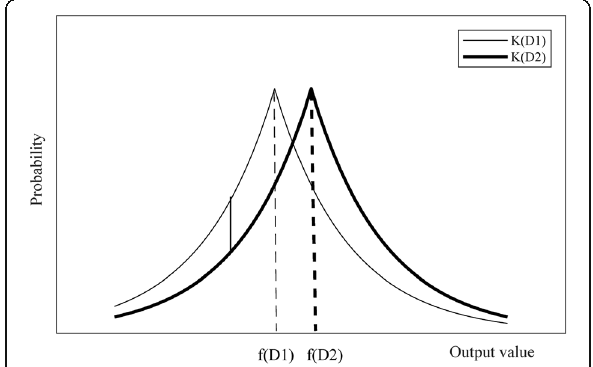
Fig. 1 Random algorithm output probabilities on neighboring data